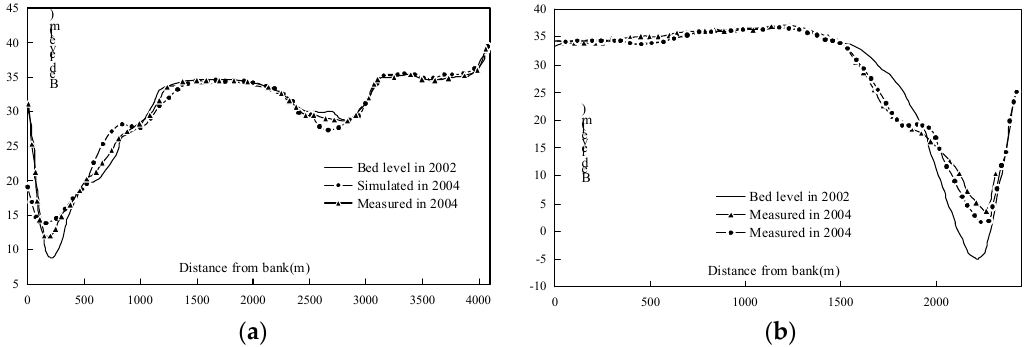
Figure 5. Measured and calculated bed deformation at various typical cross sections. ( a ) cross section S3 and ( b ) cross section S4.